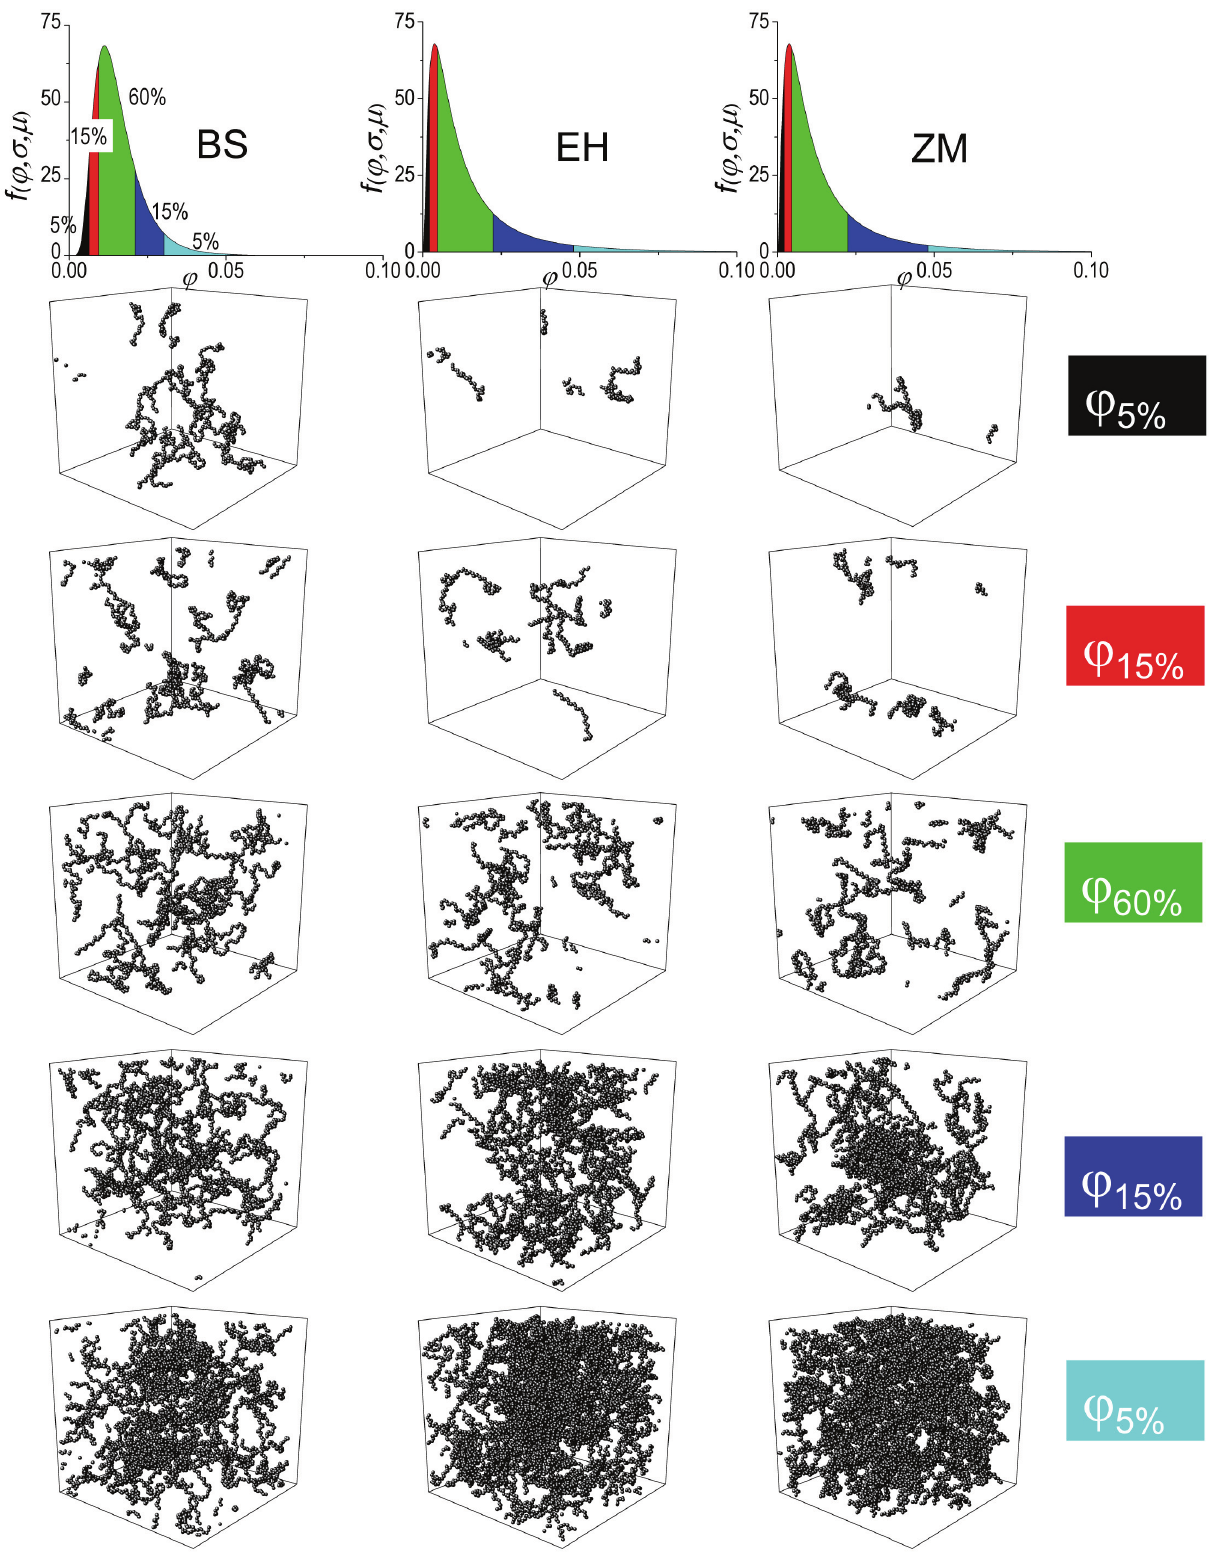
Figure 4. Molecular distribution of 2 wt % levan in space, calculated from interaction parameters presented in Table 1 and the best-fit shape para- meters from Figure 3. On the right-hand side of the figure index of ϕ represents the probability to encounter a characteristic subspace with the lo- cal ϕ in a levan sample. Assumptions: ρ (H O) = 9.47 × 10 –6 cm -2 , ρ (levan) = 1.31 × 10 –5 cm –2 , levan mass density = 1.45 g/cm 3 . The size of the mo- 2 nomer bead (5.2 Å) is depicted in proportion to the side-length of the subspace box (300